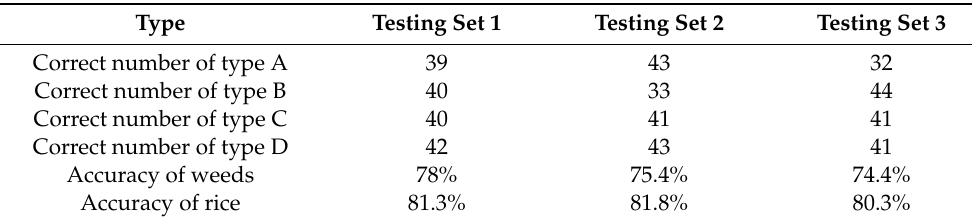
Table 7. Network accuracy results for group III.